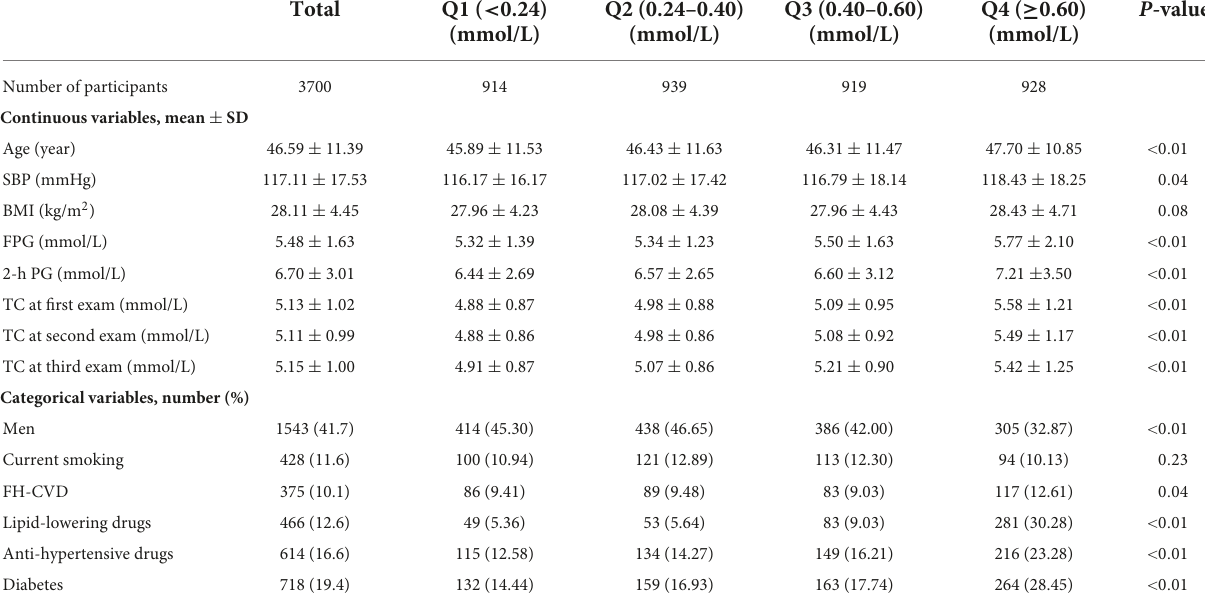
TABLE 1 Characteristics of participants according to the quartiles of total cholesterol variability (measured as standard deviation): Tehran Lipid and Glucose